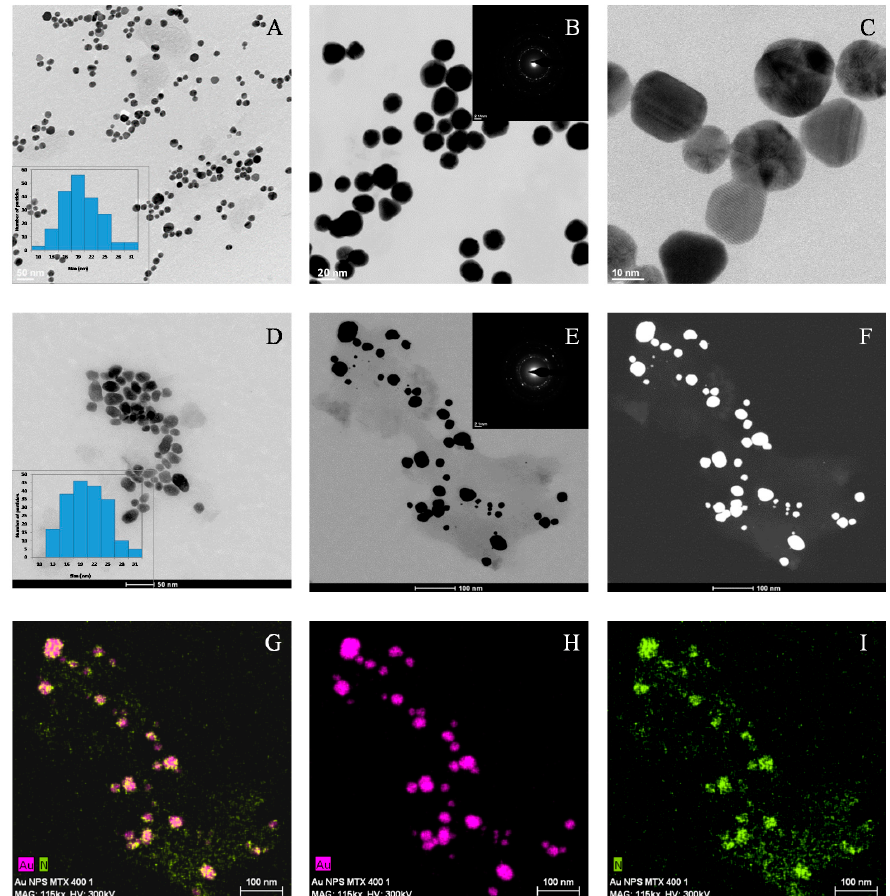
Figure 3. ( A ) HAADF image of a representative group of AuNPs. ( B ) SAED image showing the presence of a gold nanocrystalline phase. ( C ) HRTEM lattice fringe image of AuNPs showing multiple domains. ( D ) HAADF image of a representative group of AuNP–MTX conjugates. ( E ) Dark field